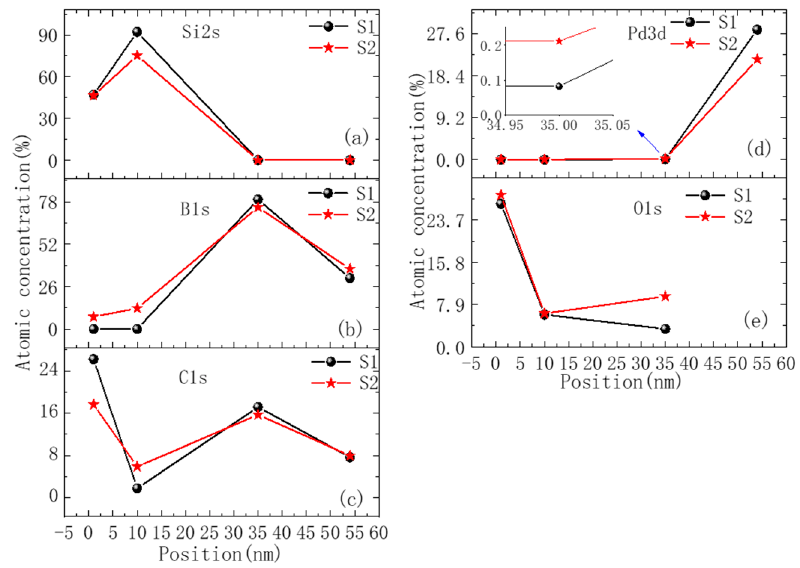
Figure 7. The relative content distribution of each element along the depth of the sample as measured using XPS. Figures ( a – e ) are the relative contents of Si, B, C, Pd, and O, respectively. A similar trend was found in the Si capping layer. For the S1 sample, no B element was detected, whereas the concentration of B in the Si capping layer of the S2 sample was 12.7%. The C content at the S2 sample position was 5.9%, which was larger than the S1 sample (1.8%). No Pd element was detected in the Si capping layer of either